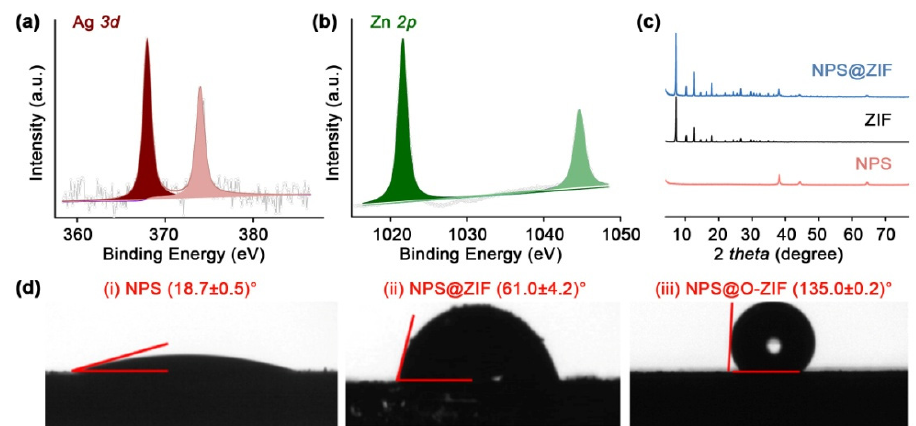
Figure 2. XPS characterization of NPS@ZIF at ( a ) Ag 3d and ( b ) Zn 2p binding energy. ( c ) XRD patterns of NPS, ZIF, and NPS@ZIF. ( d ) Corresponding static water contact angle tests.